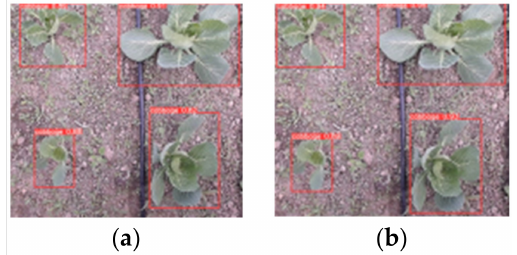
Figure 11. Normal image. ( a ) With motion-blur augmentation; ( b ) Without motion-blur augmentation.